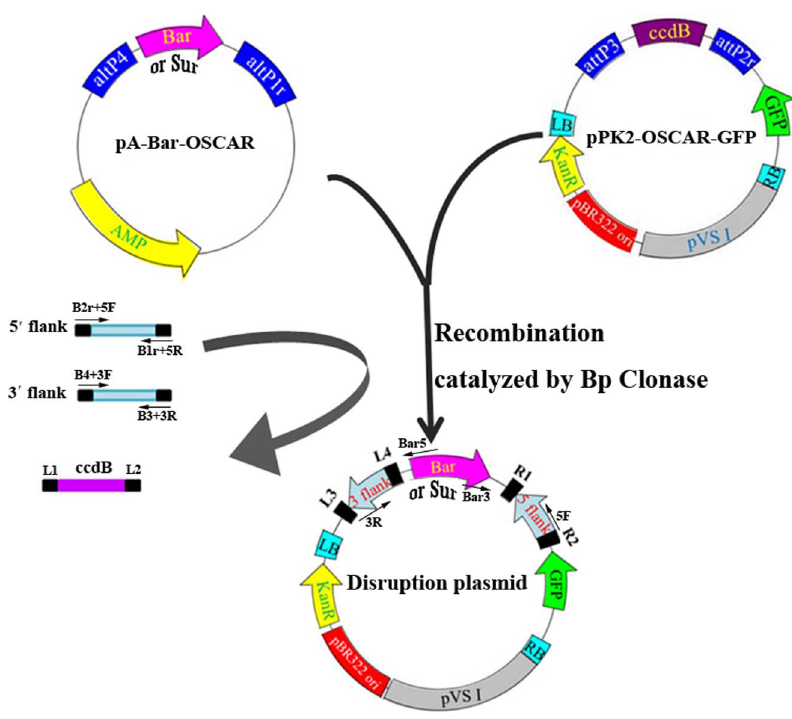
Figure 1. The modified OSCAR methodology for construction of gene disruption plasmids. The donor plasmids contain the cassette of the herbicide-resistance genes Bar or Sur . The recipient binary plasmid pPk2-OSCAR-GFP was used for construction of gene disruption plasmids in E. coli . Primers B2r + 5F/B1r + 5R and B4 + 3F/B3 + 3R were used for cloning 5 9 and 3 9 flanking sequences of the gene to be deleted, respectively. B2r, B1r, B4 and B3 are recognition sites of Bp Clonase for recombination, which were added to 5 9 end of their respective primers. Primer 5F (or B2r + 5F) and Bar3 (Sur3 when pA-Sur-OSCAR used) and Bar5 (Sur5 when pA-Sur-OSCAR used) and 3R (or B3 + 3R) were used to confirm the construction of the gene disruption